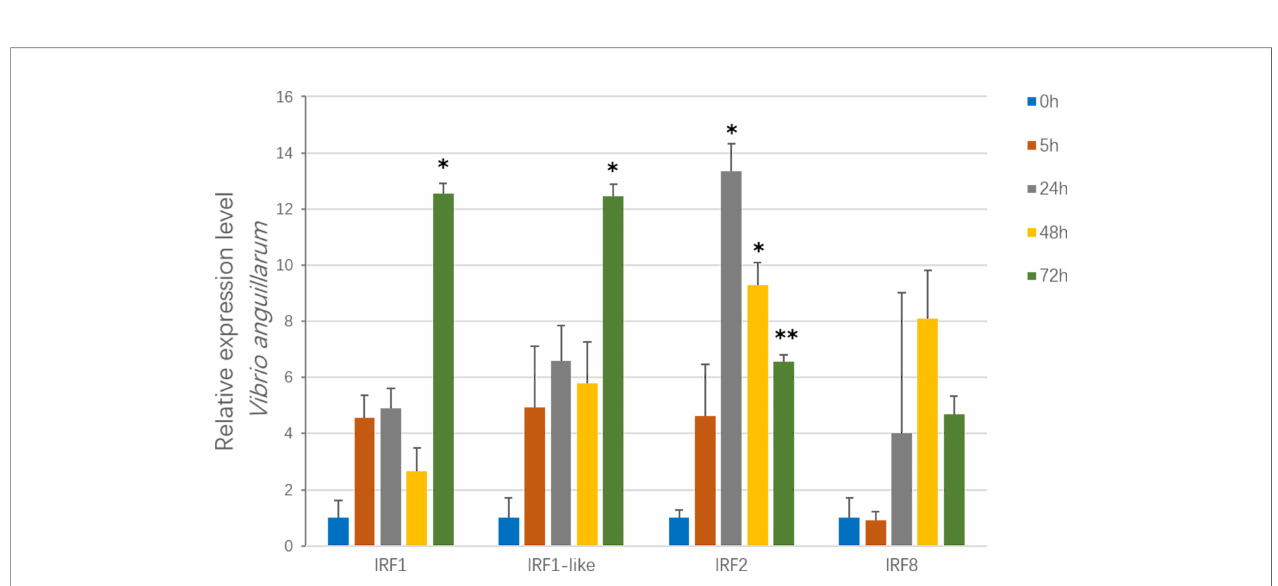
FIGURE 5 | Expression of CfIRF genes after challenge with the V. anguillarum . Vertical bars represent the mean ± S.E. ( N = 10). The asterisks indicate signi fi cant differences (* p < 0.05, ** p < 0.01).